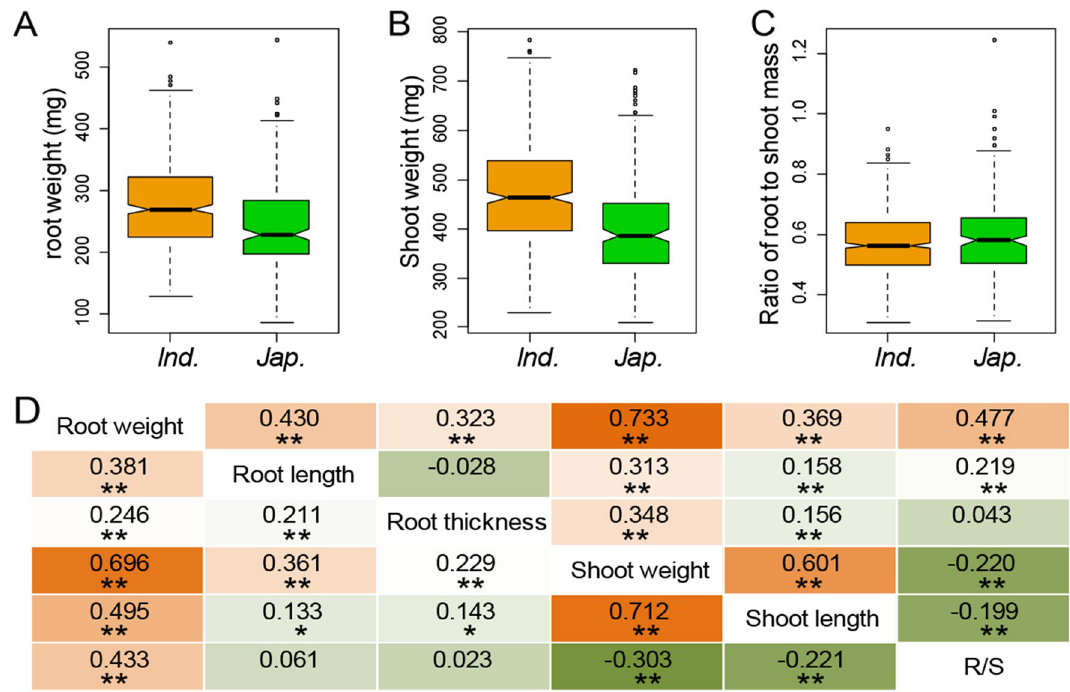
Figure 1. Subpopulation characteristics and trait correlations of six biomass traits. Phenotypic distributions of ( A ) root weight, ( B ) shoot weight and ( C ) ratio of root-to-shoot mass (R/S), divided by the indica and japonica